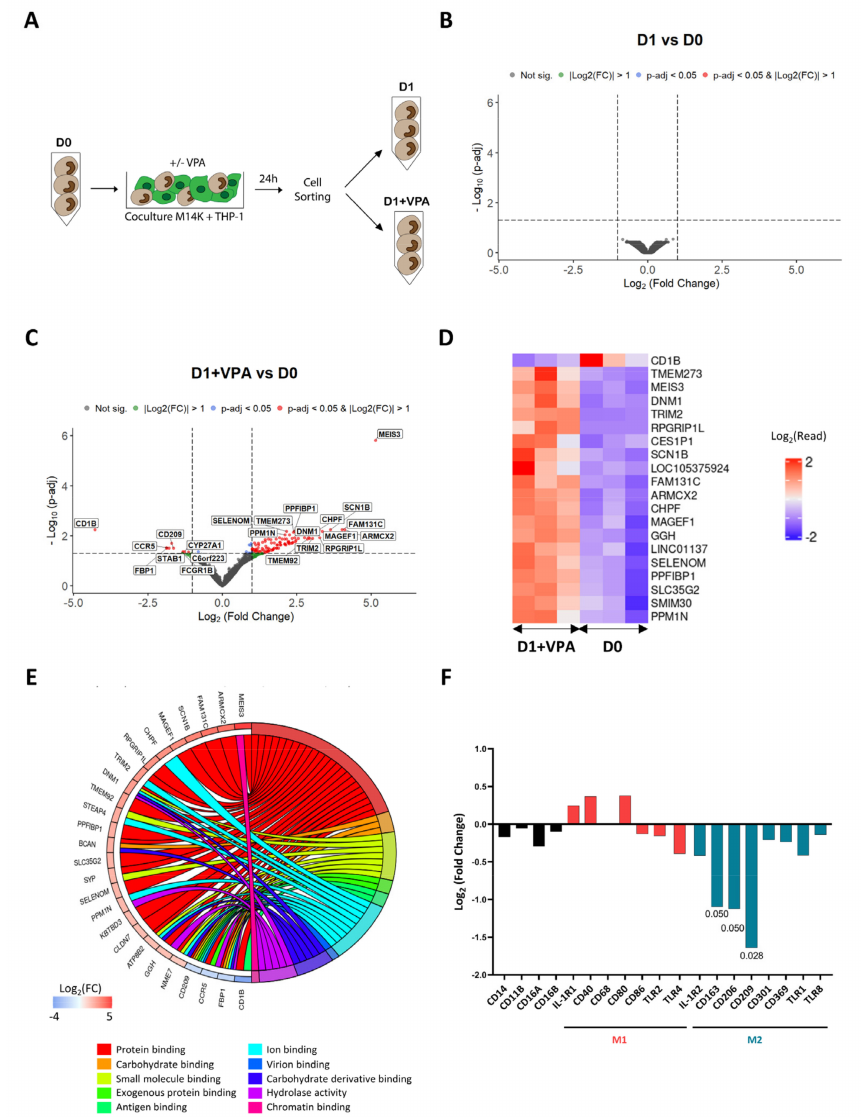
Figure 4. Transcriptomic profile of VPA-treated monocytes after cocultivation with MPM cells. ( A ) Experimental design. Blood-derived monocytes (D0) were cocultured with CFSE-labeled M14K cells in the absence (D1) or presence of VPA (2 mM) (D1+VPA) for 24 h. After coculture, monocytes were isolated using a flow cytometry cell sorter. The experiment was performed independently with monocytes isolated from 3 different healthy donors. After extraction of ribonucleic acids, mRNA was purified, converted to cDNA libraries, and sequenced with a Novaseq 6000 device. ( B ) Volcano plot of differentially expressed genes between D1 and D0 conditions with Log 2 (Fold Change) threshold: 1, p-adj threshold: 0.05, shrinkage method: ashr. ( C ) Volcano plot of differentially expressed genes between D1+VPA and D0 conditions with Log 2 (Fold Change) threshold: 1 and p-adj threshold: 0.05, shrinkage method: ashr. ( D ) Heatmap of the most significant DEGs deduced from 3 independent donors in the conditions D1+VPA and D0. The color key represents the Log 2 (read count) (DEGs) from low (blue) to high (red). ( E ) Representative chord diagram of the 10 most significant pathways from GO: Molecular Functions (GO:MF) between the conditions D1+VPA and D0. The chords show a detailed relationship between Log 2 (Fold Change) of DEGs (left semicircle) and their enriched GO:MF pathways (right semicircle). The color key represents the Log 2 (Fold Change) from low (blue) to high (red). The GO enrichment analysis was performed by considering all significant genes (p-adj < 0.05). ( F ) Log 2 (Fold Change) of selected membrane receptors between the conditions D1+VPA and